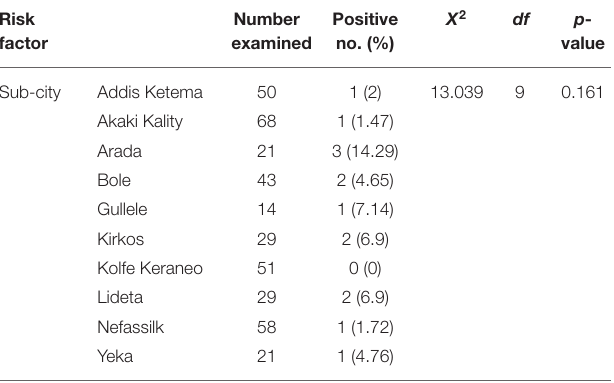
Number Positive examined no.